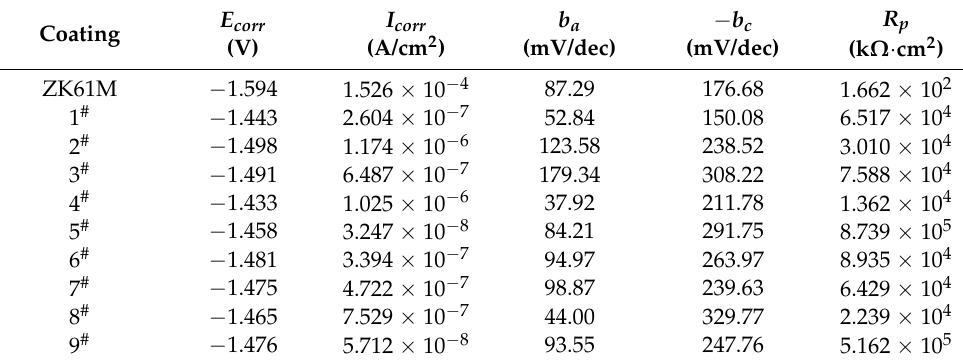
Figure 9. Potentiodynamic polarization curves of ZK61M magnesium alloy and MAO coatings (1 # –9 # ) in 3.5 wt.% NaCl solution at room temperature. Table 5. Parameter values of potentiodynamic polarization curves of ZK61M magnesium alloy and coatings in 3.5 wt.% NaCl solution at room temperature.